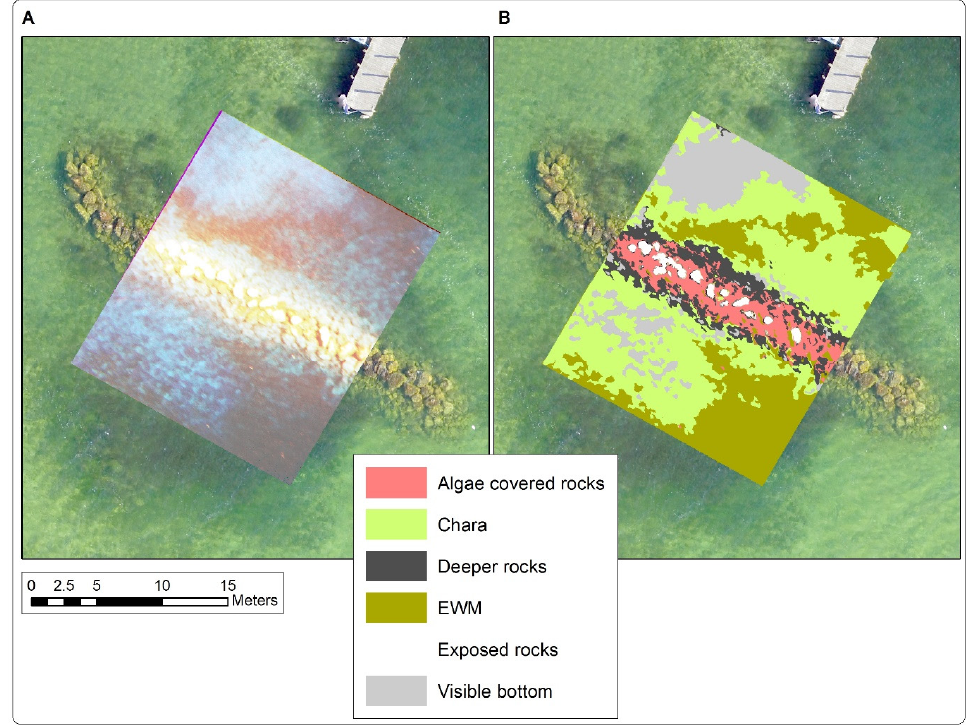
Figure 9. Neil July 2017 example result, with ( A ) Tetracam imagery and ( B ) classification result with scale parameter = 50.